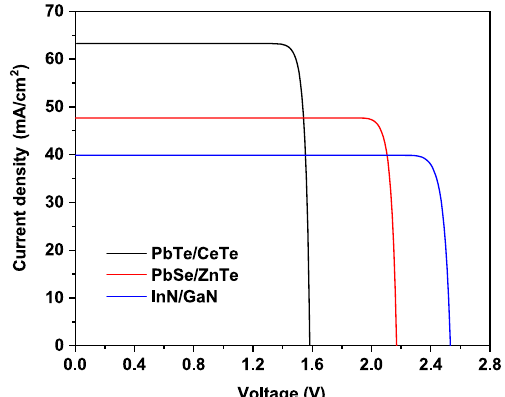
Figure 8. Current density versus voltage between CB and VB of the QD-IBSC at the full concentration at the optimum pair ( L , H ): ( L = 3.7 nm, H = 2.4 nm), ( L = 3 nm, H = 1.8 nm) and ( L = 3.4 nmn H = 1.3 nm) for PbTe/CdTe, PbSe/ZnTe and InN/GaN QD